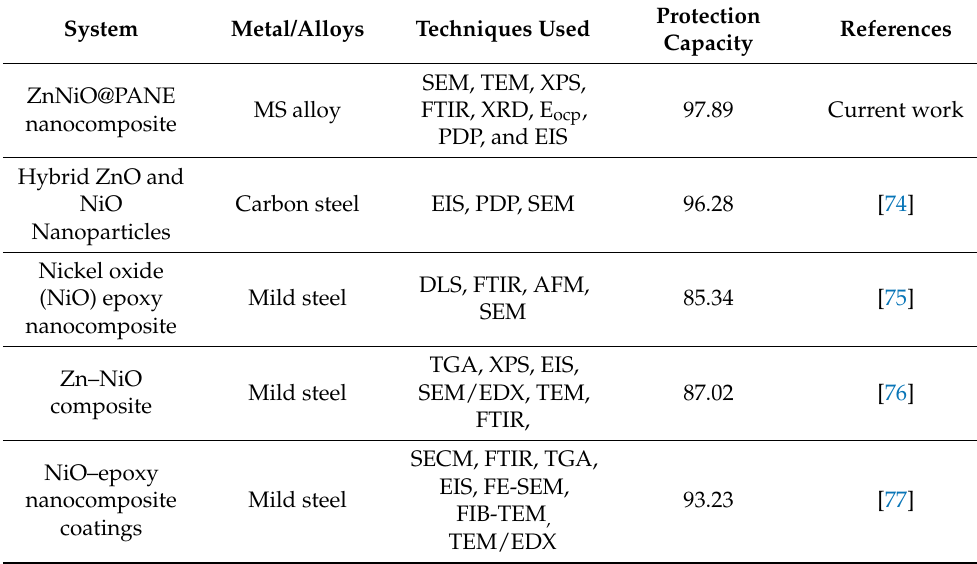
Table 5. Comparative studies with previous